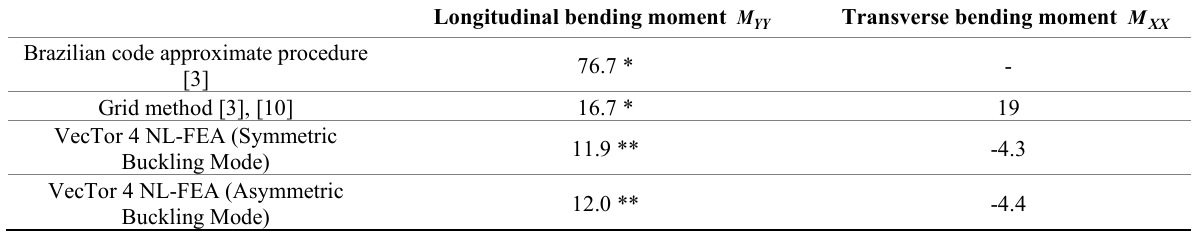
Table 3. U-shaped shear wall maximum be nding moments (kN∙m/m). Longitudinal bending moment YY